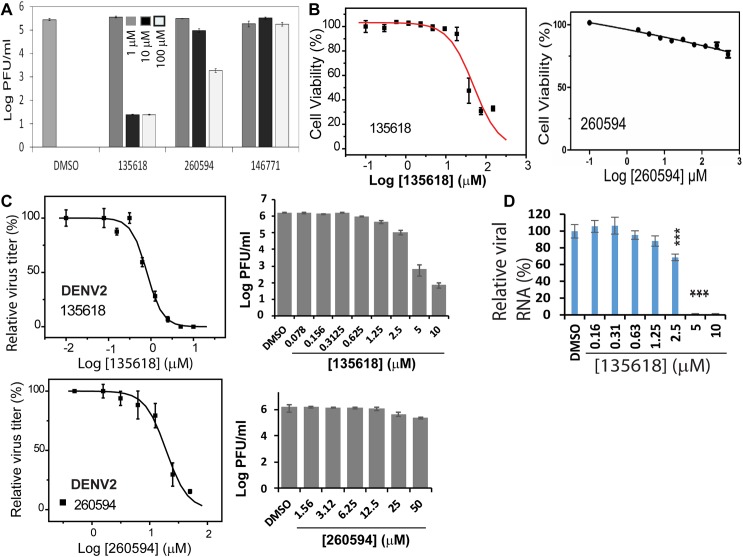
Cell viability and viral reduction activity of candidate compounds in A549 cells.(A) Inhibition of DENV2 infectivity on A549 cells by compounds NSC135618, 260594, and 146771 at a concentration of 1 μM (dark grey), 10 μM (black), and 100 μM (light grey) measured as titer of virus produced (on a log scale) relative to the DMSO control. (B) Cell viability of A549 cells in the presence of varying concentrations of NSC135618 or 260594. Cell viability for the DMSO control was set as 100%. Cell viability for compound-treated samples were set as percentage of the DMSO control. Curve fitting was performed using the Sigmoidal model within the Origin6.0 software suite. (C) Inhibition of DENV2 infectivity by varying concentrations of NSC135618 and 260594. Left: Sigmoidal curve fitting of experimental data expressed as percentage of virus titers (DMSO control was set as 100%). Right: Virus titers at indicated compound concentrations shown in log orders. (D) qRT-PCR analysis of inhibition of viral RNA from 135618-treated and DENV2-infected samples in A549 cells. Viral RNA copy number of the DMSO control was set as 100% with those of compounds treated samples as percentage of the DMSO control. For all panels, N = 3. ***, p<0.01, by one-way ANOVA.